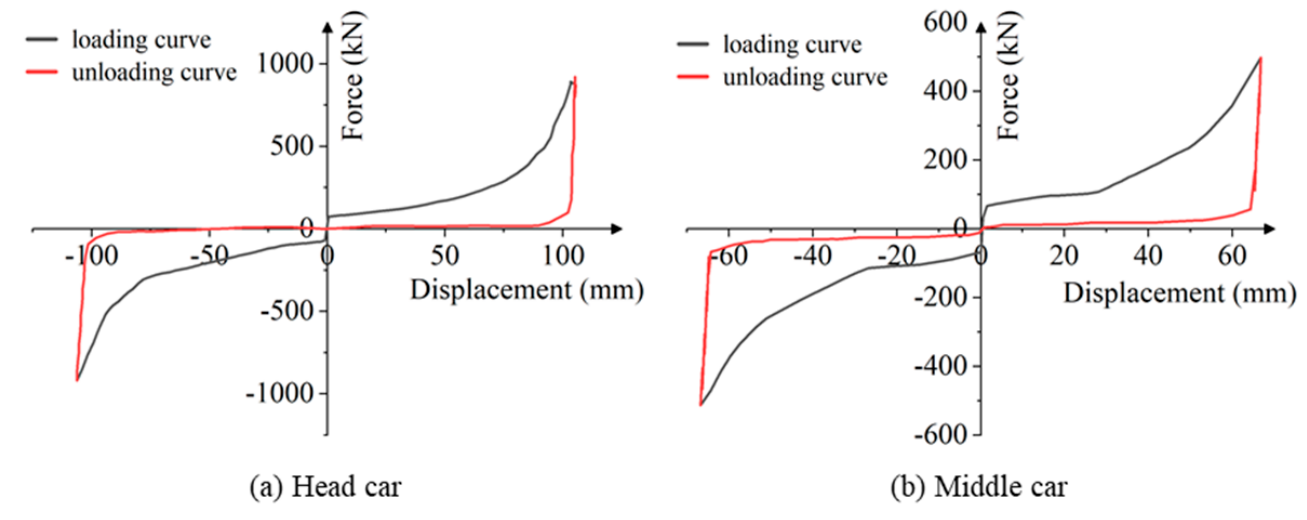
Figure 2. Loading and unloading curves of buffer.